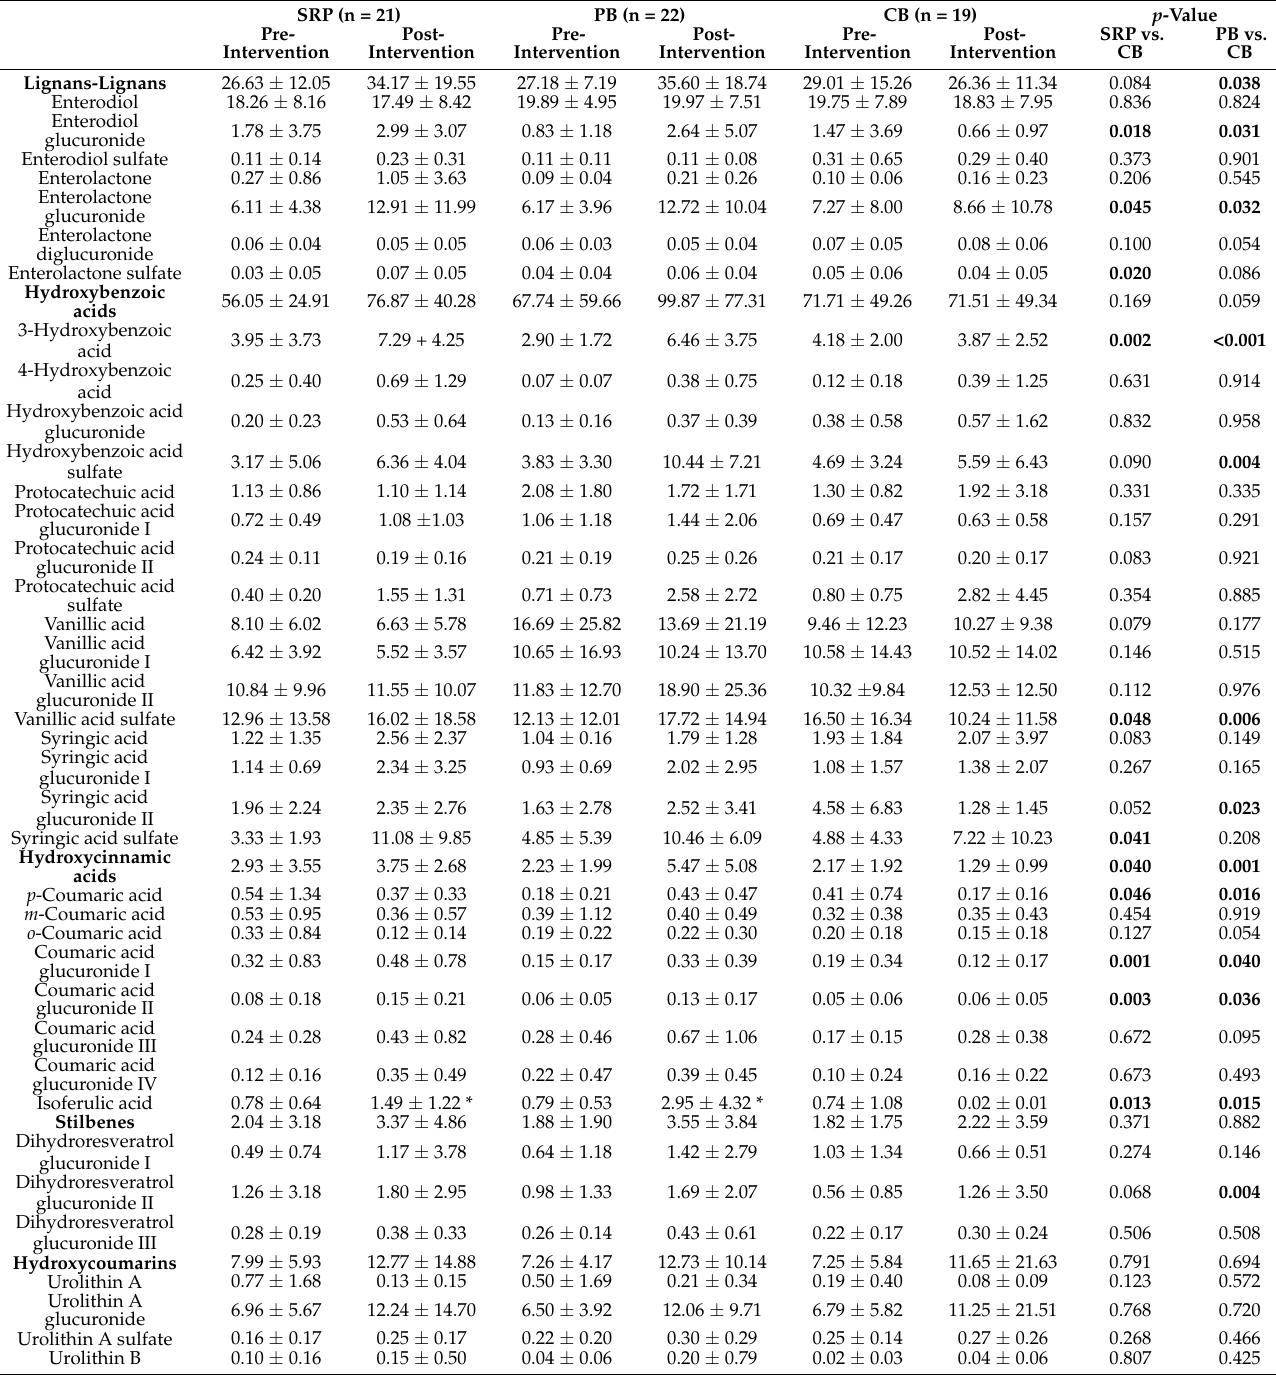
Table 2. Urinary phenolic metabolite concentrations in healthy young adults from the ARISTOTLE study before and after the